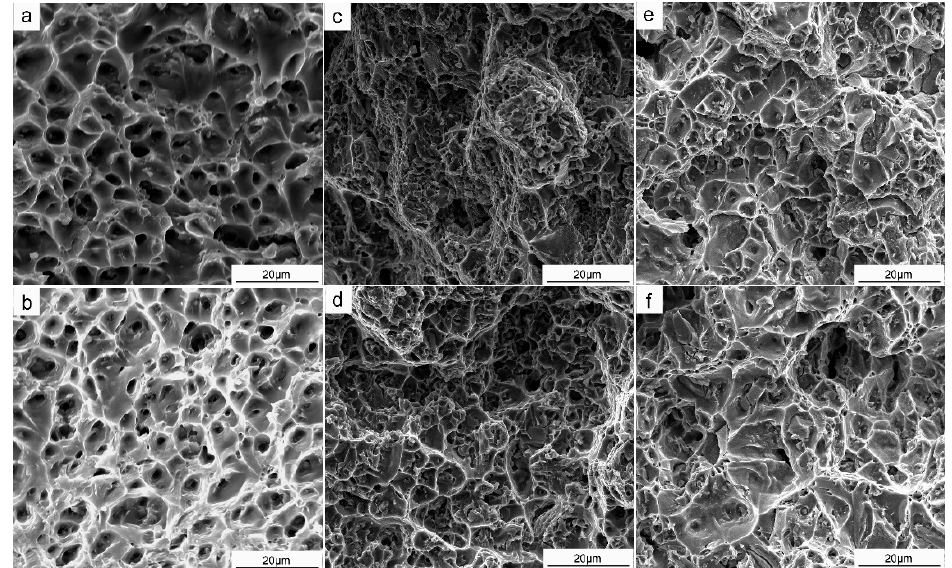
Figure 8. Fracture morphologies of the tensile samples of ( a , b ) Al-Mg alloy deposits, ( c , d ) as-deposited Al-Mg-0.3Sc alloy, and ( e , f ) Al-Mg-0.3Sc alloy deposits after heating at 350 °C for 1 h. Where a, c, and e are vertical, and b, d, and f are horizontal.